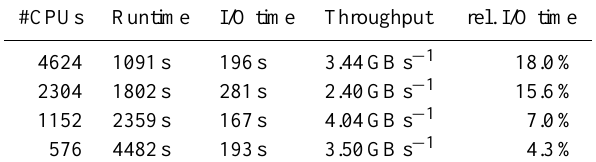
Table 1. I/O performance for a typical setup of AxiSEM on Super- MUC. The simulation parameters were as follows: 2s shortest pe- riod, 3600s simulation length, model: ak135f, vertical component, maximum source depth 700km. The resulting uncompressed wave field file has a size of 675GB. The I/O throughput is not affected much by the number of CPUs involved. The throughput between different runs varies, which is probably caused by the changing I/O load on the system.